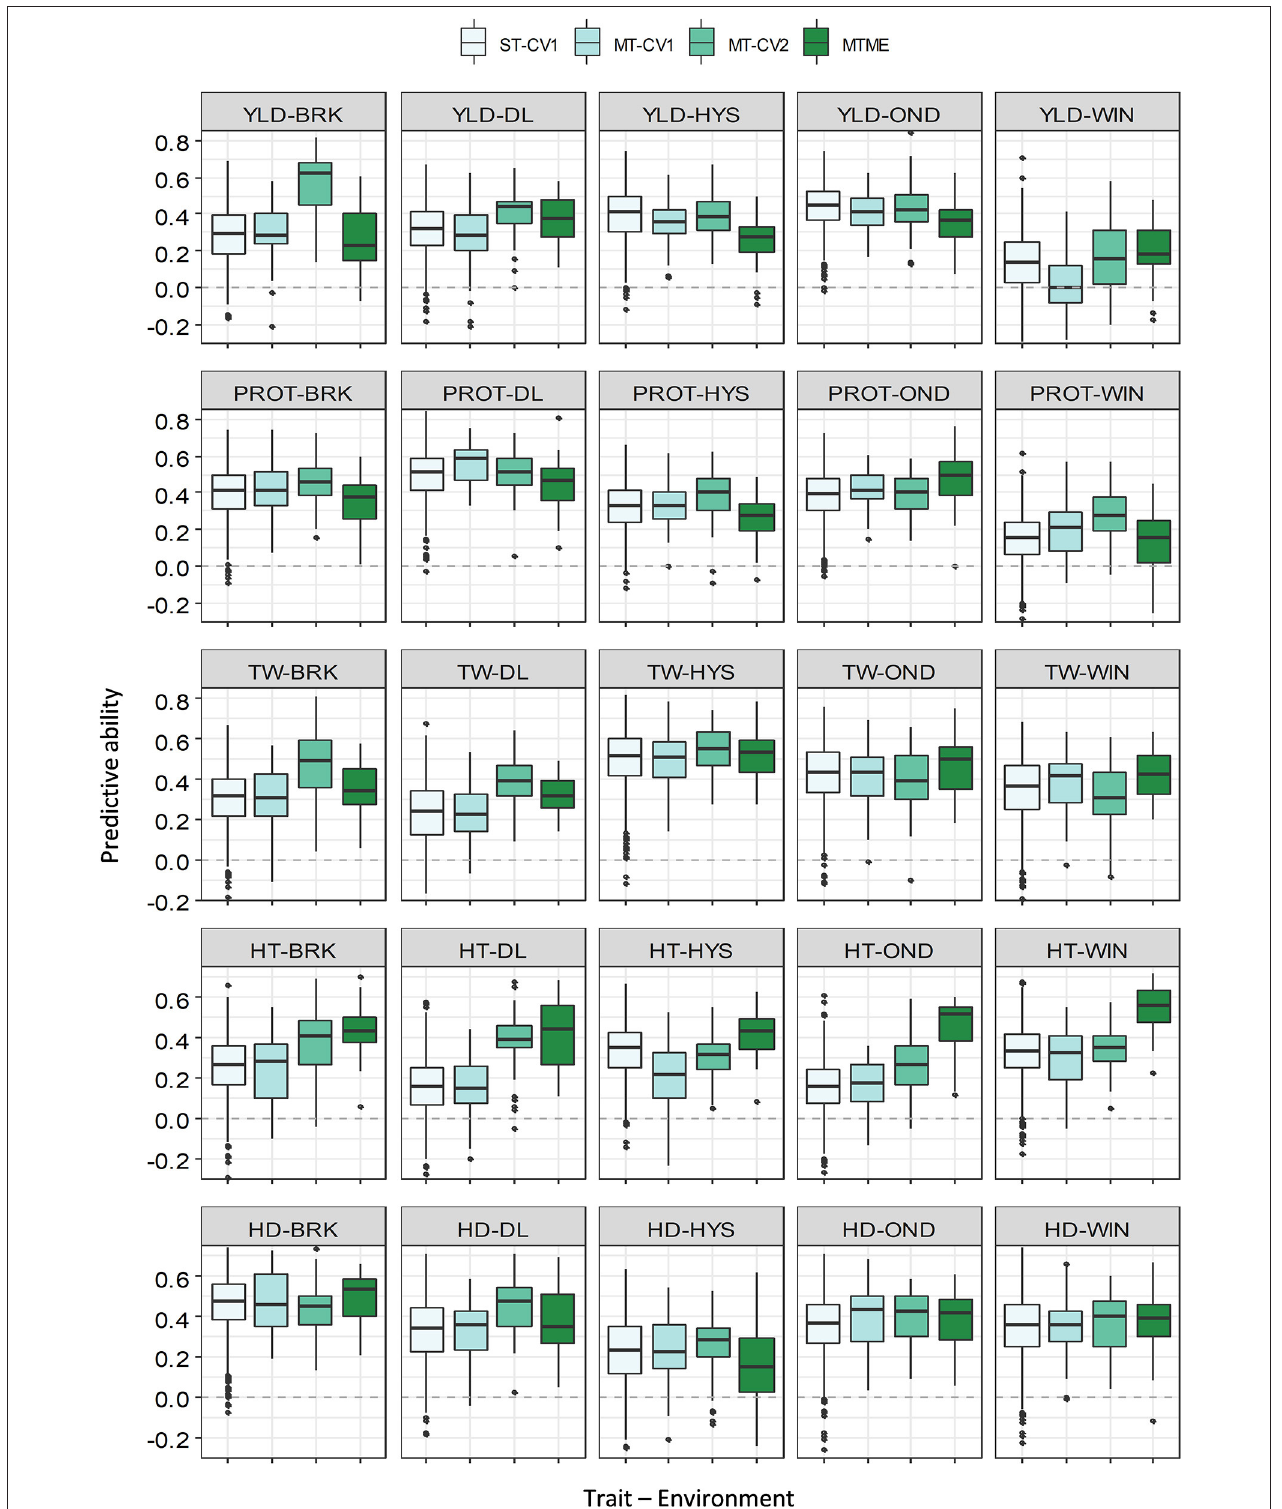
FIGURE 3 | Prediction accuracy (PA) for five agronomic traits evaluated in five environments in the growing season of 2018–19. Boxplots compare the PA using a single-trait prediction model with one cross-validation scheme (ST-CV1), a multi-trait prediction model with two cross-validation schemes (MT-CV1 and MT-CV2), and a Bayesian multi-trait multi-environment prediction model (MTME). Traits include YLD, grain yield; PROT, grain protein content; TW, test weight; HT, plant height; and HD, days to heading.